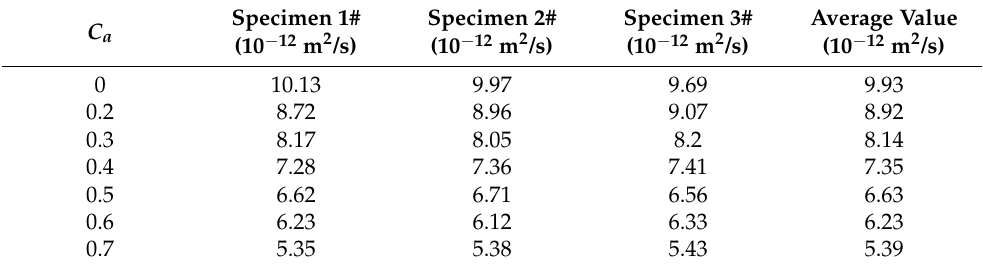
Table 4. The D c measured by